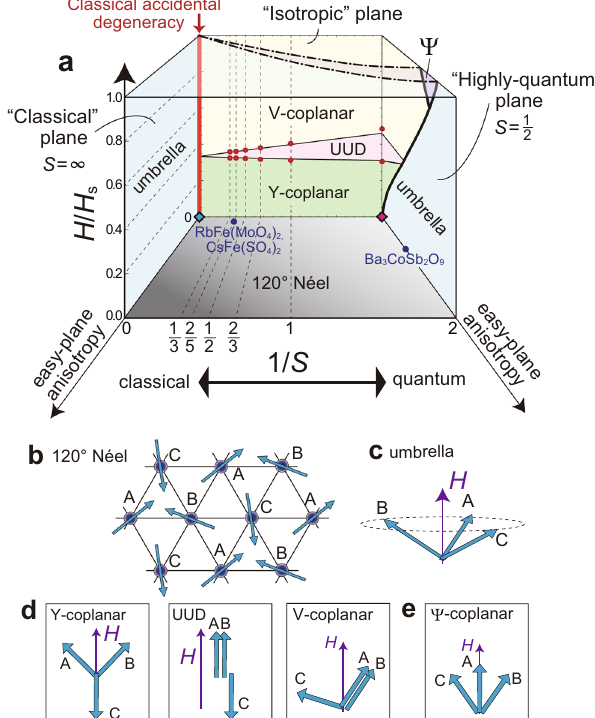
Fig. 1 Ground state of easy-plane triangular-lattice antiferromangets. a Schematic ground-state phase diagram in the space of the magnetic fi eld H scaled by the saturated fi eld strength H s , the reciprocal of spin quantum number S , and easy-plane anisotropy ⊥ H . The phase boundaries on the plane of no anisotropy (on the back face) are obtained by the 1/ S expansion method with the “ cutting-at-1/3 ” procedure 18 (solid lines) and coupled- cluster method 19 (red dots). Those on the planes of S = 1/2 and H / H s → 1 (on the right and top faces, respectively) are sketches based on the predictions of ref. 20 and refs. 21 – 23 , respectively. The approximate locations of some relevant materials 69 – 73 are indicated by the fi lled circles. b - e Illustrations of the sublattice spin moments in each phase appearing in a